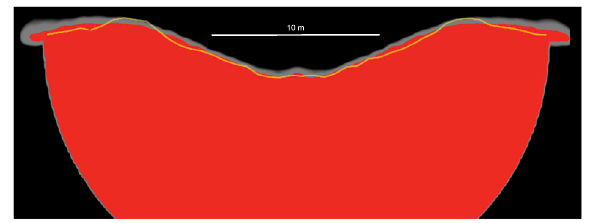
Fig.5|Comparisonoftwonumericalapproaches. Shownaretheresultsofdirect SPH (this work) and SPH-SSDEM simulations 36 . The crater pro fi le obtained by the hybrid SPH-SSDEM simulation (yellow line) is over-plotted on the results of the direct SPH simulation. Indicated in grey is the uncertainty due to the SPH kernel interpolation and associated smoothing length. The fi nal crater size and mor- phology are in good